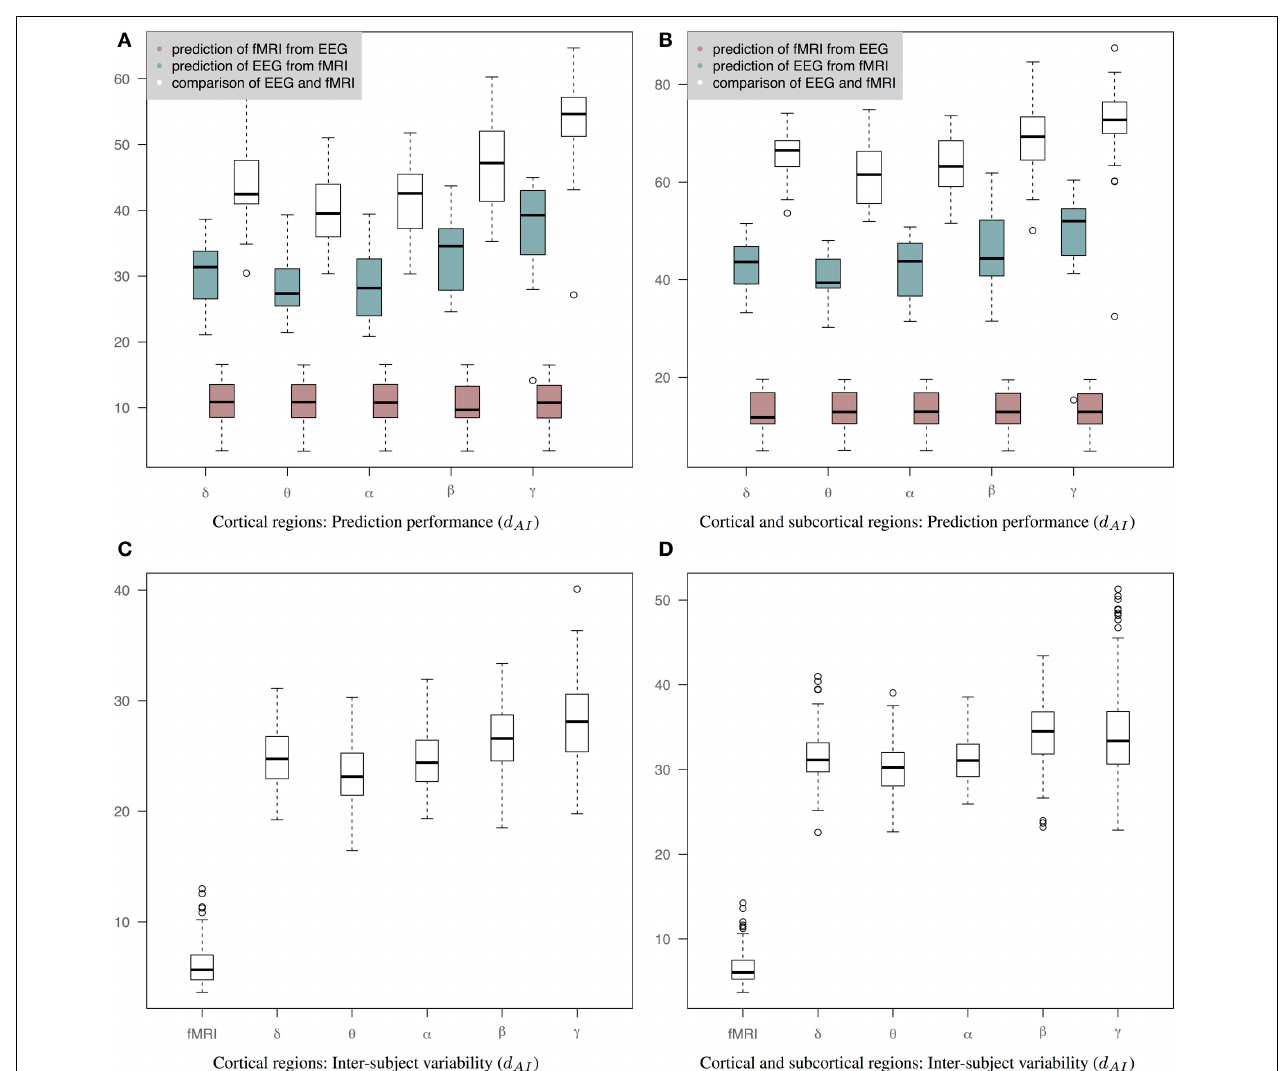
FIGURE 5 | Results of prediction performance (WTS). This figure presents results of prediction performance and inter-subject variability when both fMRI and EEG precision matrices are estimated based on all time samples. The distance between the rs-fMRI precision matrices and each of the EEG frequency banded precision matrices estimated with d AI . The smaller the distance the more similar the connectivity matrices should be. (A) It shows results based only on cortical regions that summarize the prediction performance of fMRI from EEG (brown box-plots) and vice-versa (green box-plots) across bands, as well as the distance between the fMRI precision